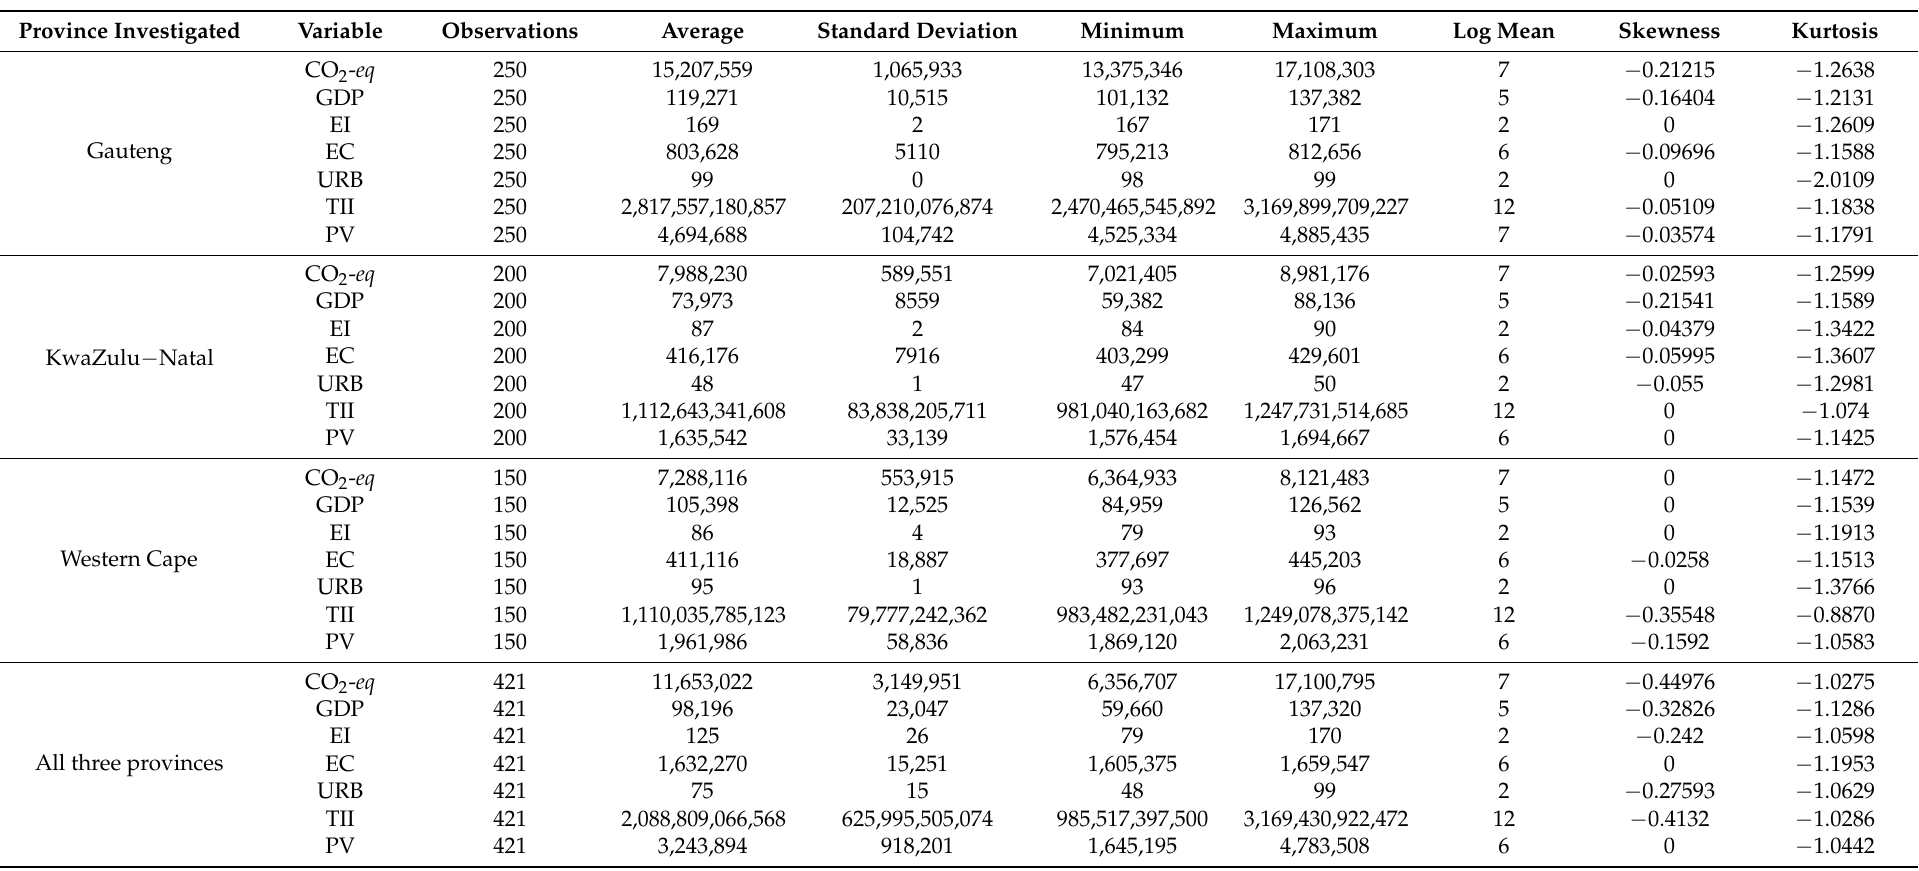
Table 4. Description of the econometric statistics for the main